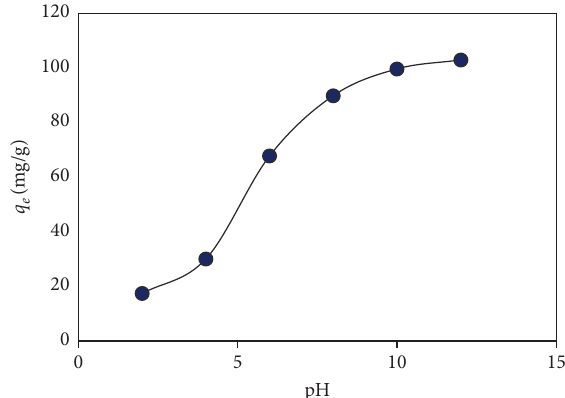
Figure 11: Effect of pH solution on adsorption Pb (II) on S-CNs.